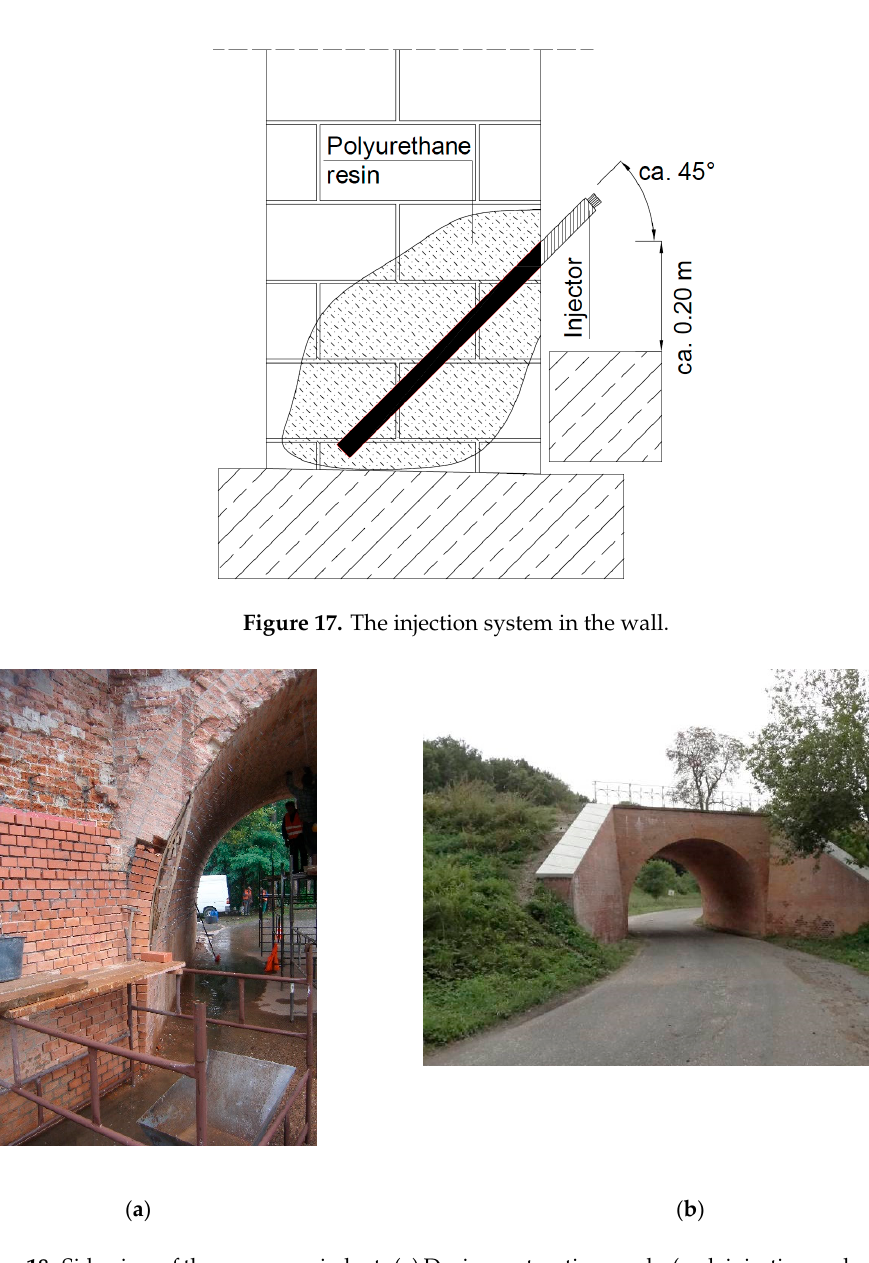
Figure 18. Side view of the masonry viaduct: ( a ) During restoration works (arch injection and rebuilding of the wings), ( b ) after